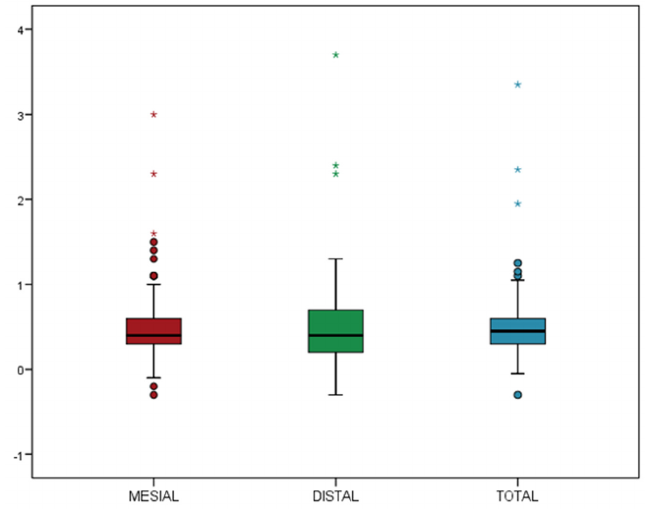
Figure 2. Box plot of the mean mesial, distal, and mean of both sites for MBL at 1-year follow-up. The box contains 50% of the cases, the median is the horizontal line that divides it. The upper and lower edges of the box correspond to the 1st and 3rd quartiles that represent 25% and 75% of the sampling, respectively. Whiskers in the box plots extend to the acceptable range of values (above which are the outliers (circles) and the extreme (asterisks) cases, respectively).